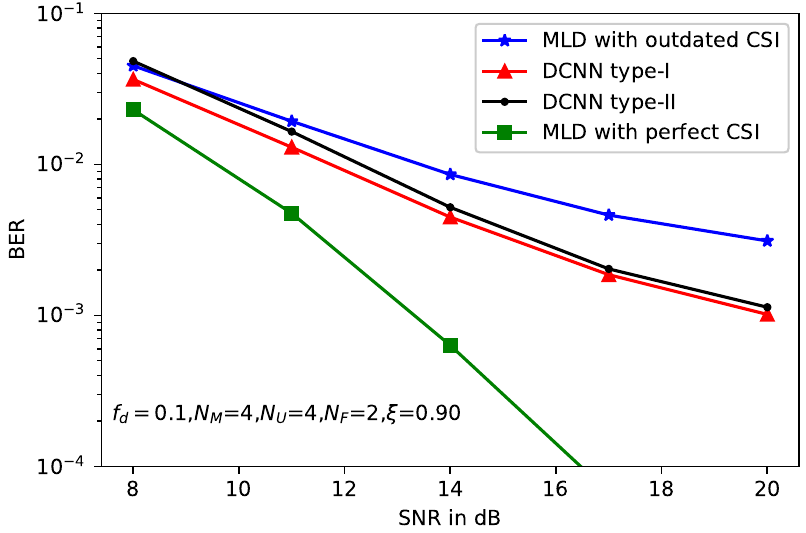
Figure 5. BER performance of deep learning-based MLD with ξ =